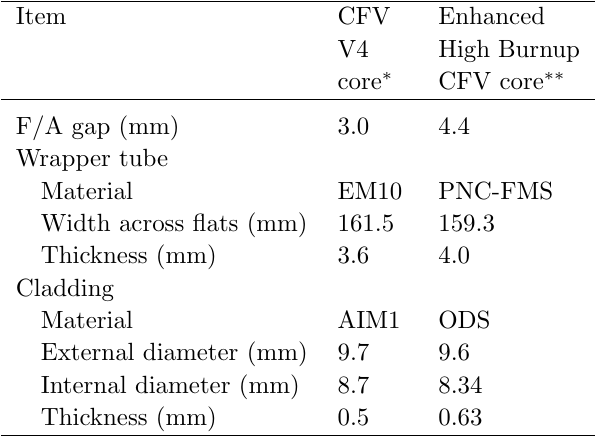
Table 3. Fuel sub-assembly (F/A) design – Main